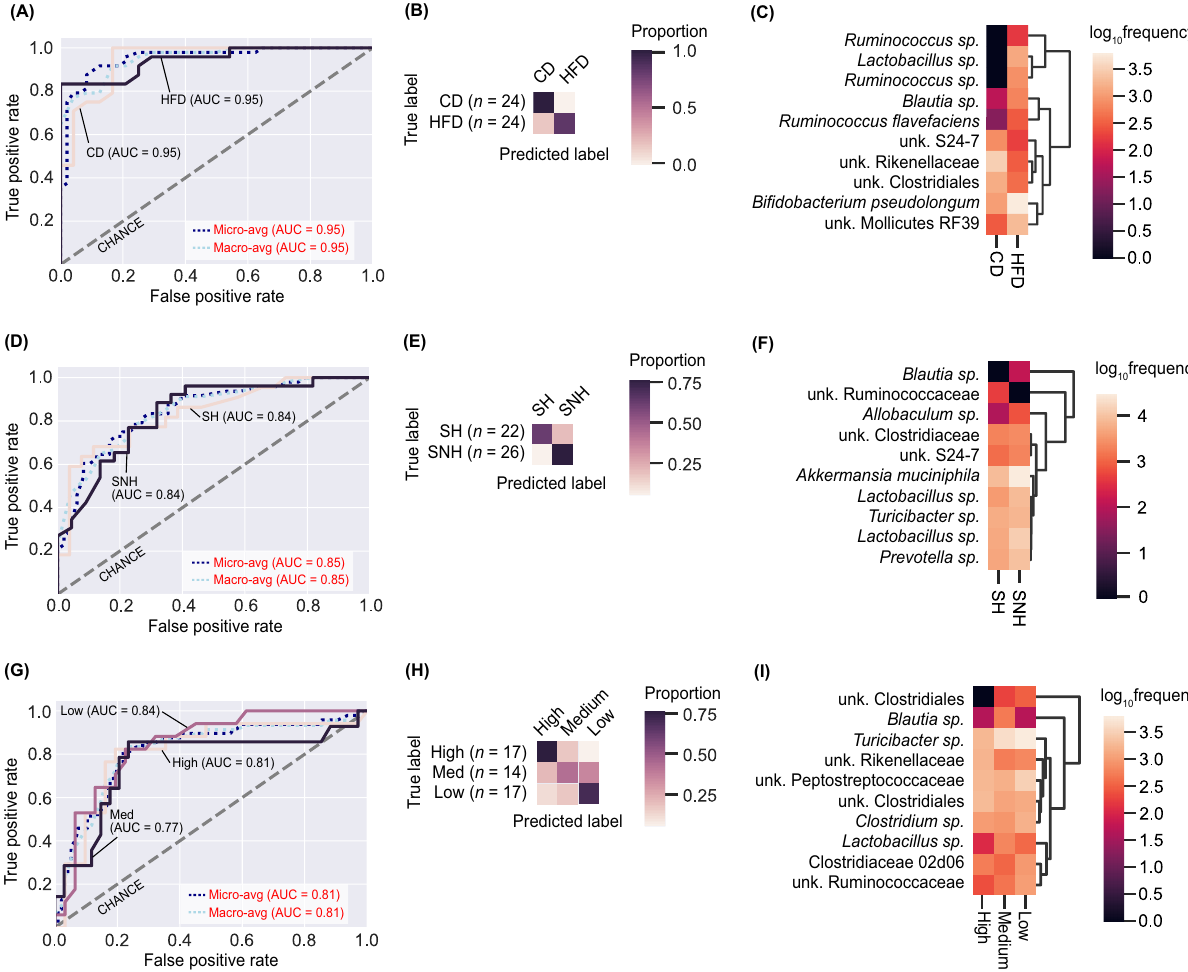
Macro- and micro-average values for the prediction of samples to F 1 offspring observed to have been reared in high, medium, or low maternal care conditions based on features of the fecal microbiome were additionally greater than chance alone (AUC = 0.81, 0.77, and 0.84, respectively; Fig. 6G). Predictive accuracies for each clas- sification level shown in Fig. 6G and the confusion matrix in Fig. 6H demonstrate that the medium maternal